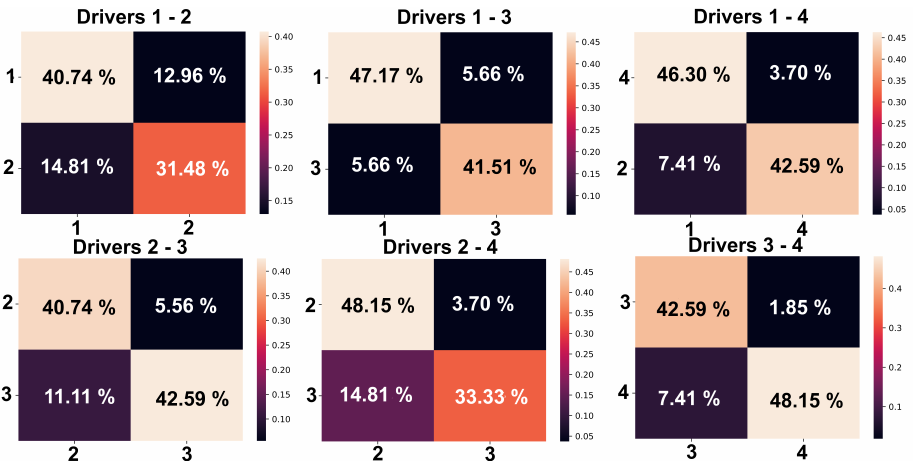
Figure 7. Percentage confusion matrices obtained in the classification of two drivers using 3 statistical variables selected by